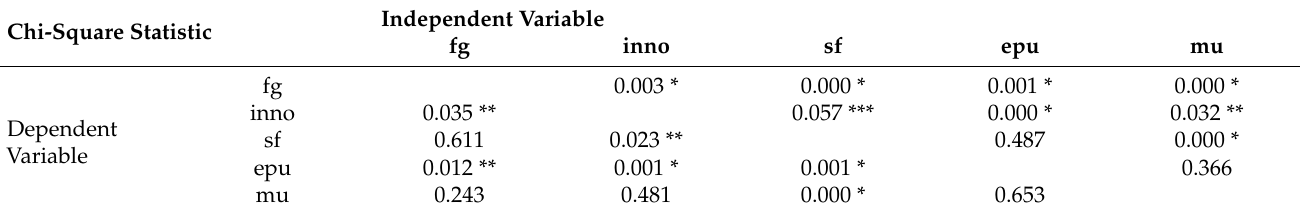
Table 6. Granger causality test.